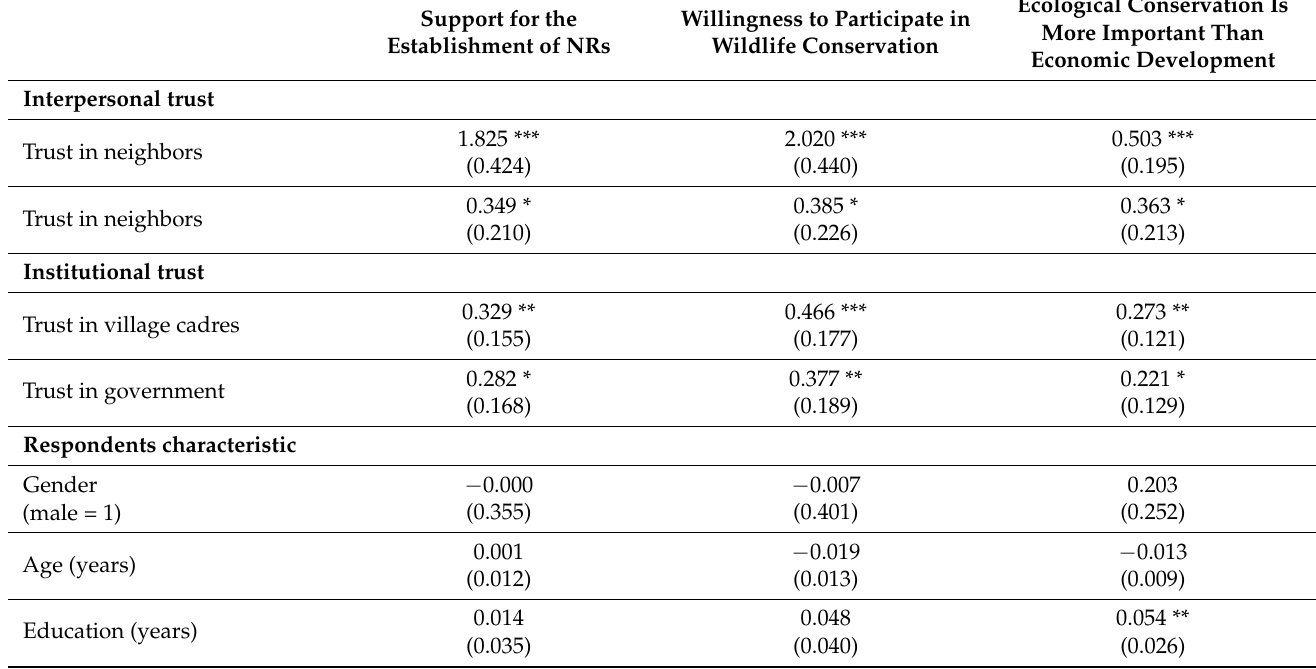
Table 2. Regression results of the effects of social trust on rural households’ conservation